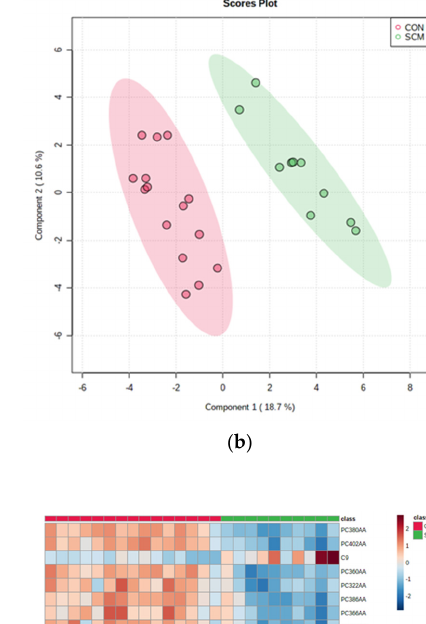
were able to differentiate between both classes, even during pathway analysis. For exam- ple, as seen on the VIP plot (Figure 3c), pyruvate and lactate were found to be higher in pre-SCM cows than CON cows at − 4 weeks prepartum. The top scoring metabolites from the PLS-DA contributed the most to the separation of clusters. In particular, PC aa 38:0, PC aa 40:0, C9, PC aa 36:0, and PC aa 32:2 (Figure 3c)